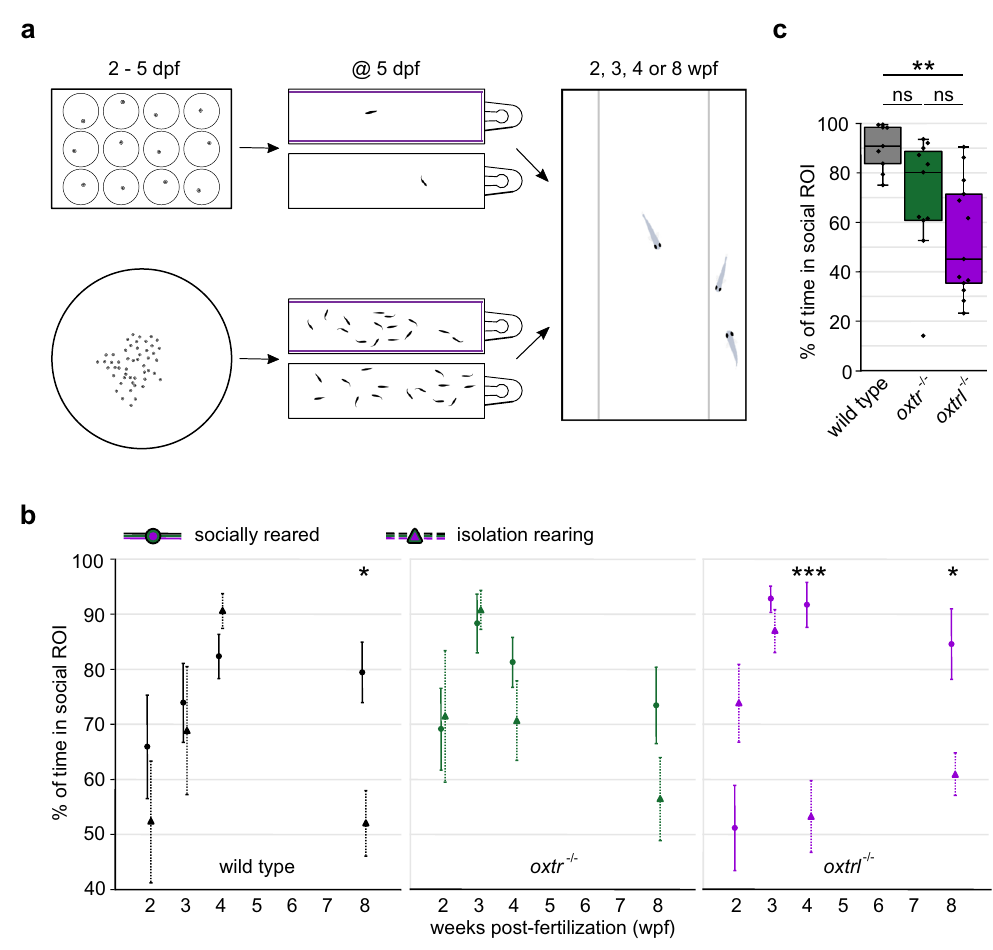
Figure 2. Isolation rearing impairs the maintenance, but not the development of social preference. ( a ) Rearing conditions: Experimental fish were raised in isolation (2–5 days post-fertilization (dpf) in 12-well plates, from 5 dpf until experiment in 1.1L tanks with visual barriers (here shown in purple) in every second tank) or with conspecifics (2–5 dpf in a dish with 145 mm diameter, from 5 dpf until experiment in 1.1L tanks with visual barriers in every second tank at densities of 10–15 fish/L). The social preference test was performed at 2, 3, 4 or 8 wpf. ( b ) The development of social preference was not influenced by isolation rearing. Similar to the phenotype observed for socially reared fish, knocking-out one of the Oxytocin receptors led to an accelerated development of social preference in isolated fish. Isolation rearing impaired the maintenance of social preference, but 4 wpf old oxtr −/− fish were less susceptible to isolation. Values are reported as mean ± standard error of the mean (s.e.m.). Asterisks represent the statistical comparison of rearing conditions (social vs. isolation) in different age groups of each genotype. Data for socially reared fish are also presented in Fig. 1b. n(isolated wildtype, 2 wpf) = 11, n(isolated wildtype, 3 wpf) = 11, n(isolated wildtype, 4 wpf) = 9, n(isolated wildtype, 8 wpf) = 16, n(isolated oxtr −/− , 2 wpf) = 9, n(isolated oxtr −/− , 3 wpf) = 18, n(isolated oxtr −/−